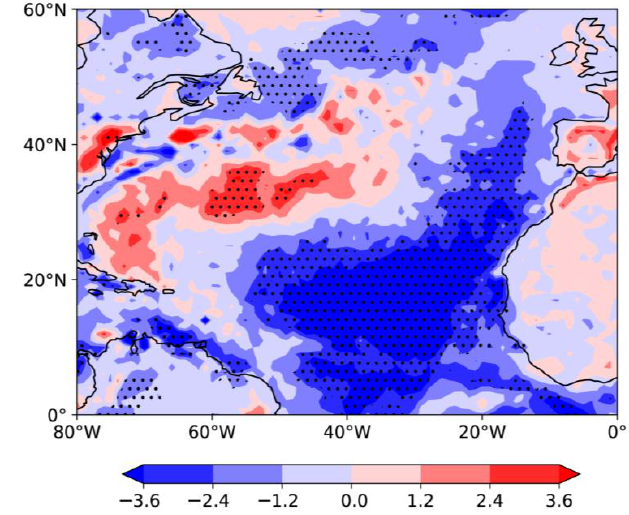
Figure 11. Regression of summer latent heat flux (shading, units: W · m − 2 ) onto the TSI. The latent heat fluxes significant at the 95% confidence level are dotted.